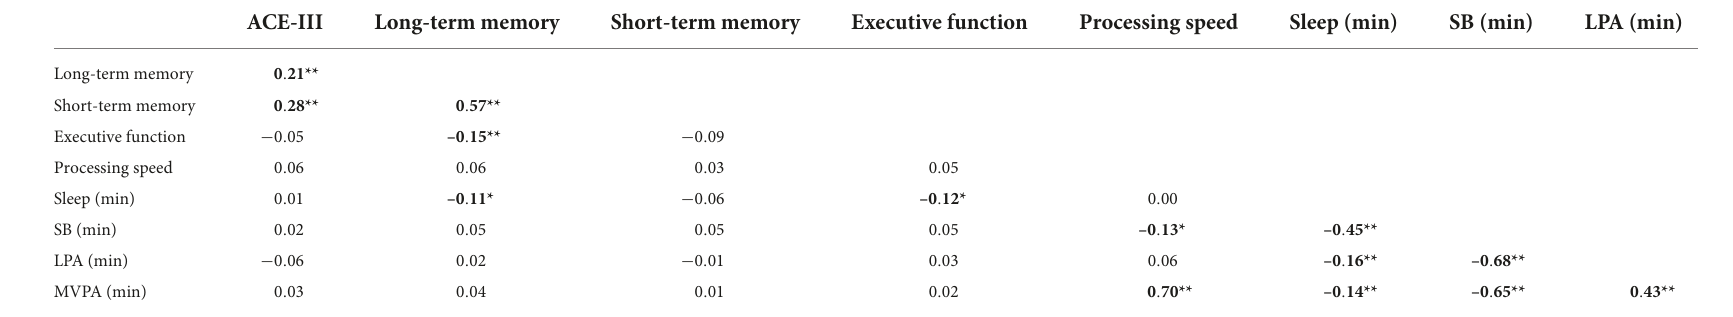
TABLE 3 Pairwise correlations between time-use variables and cognitive outcomes.